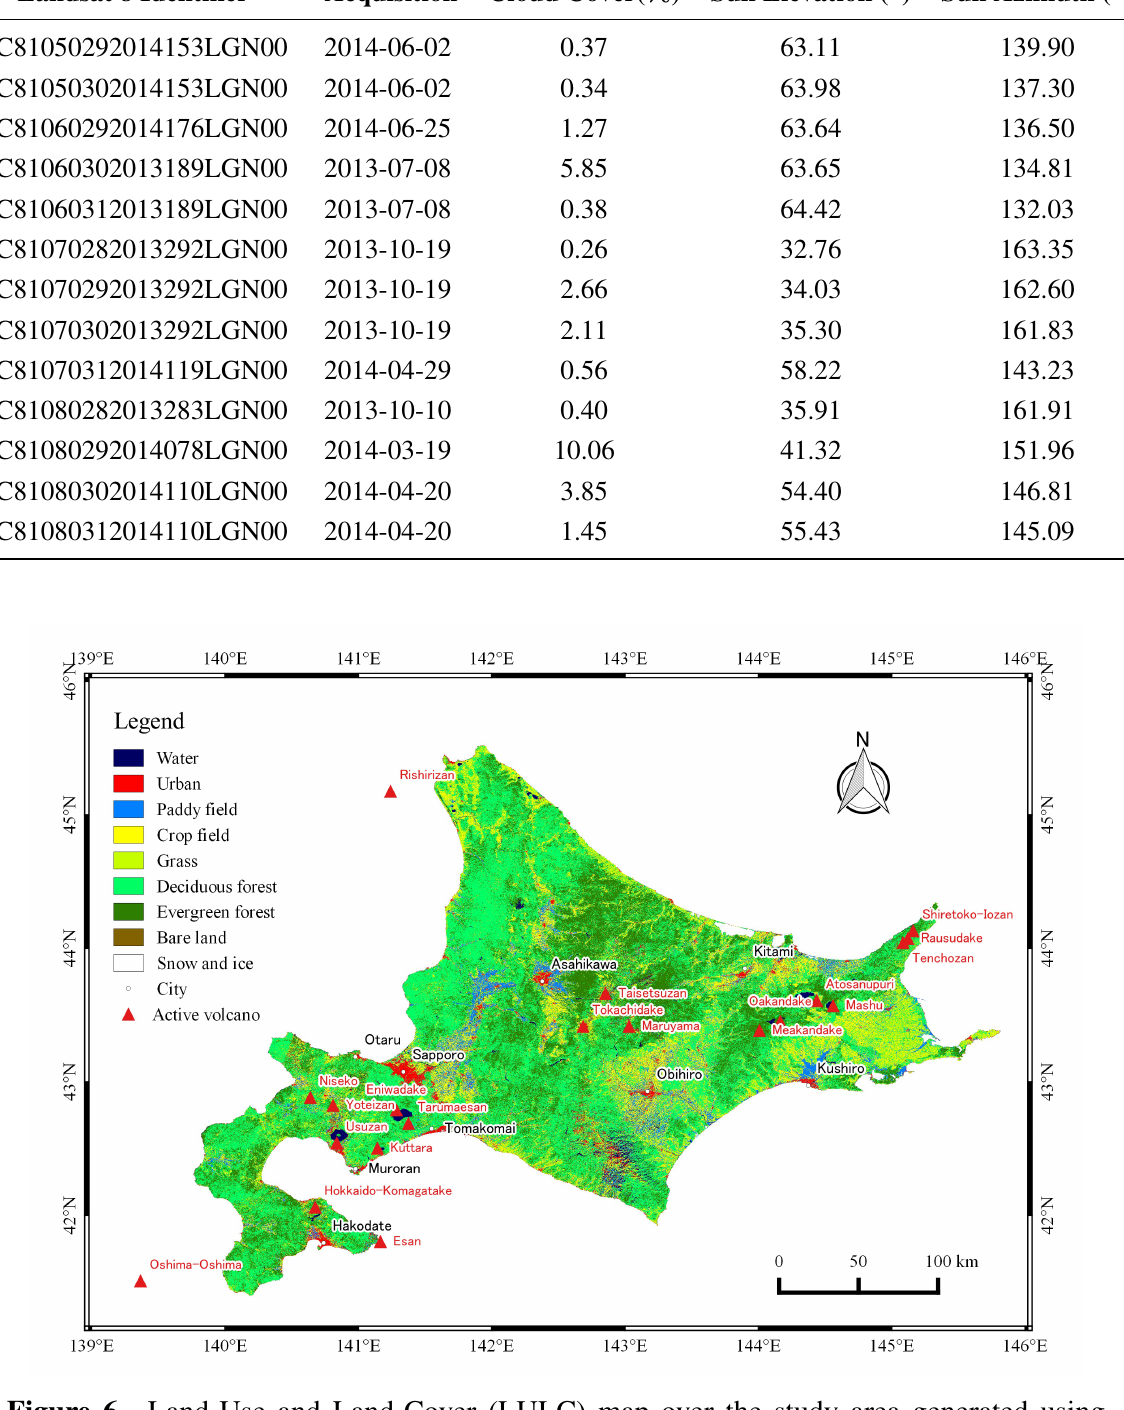
Figure 6. Land-Use and Land-Cover (LULC) map over the study area generated using the Advanced Land Observing Satellite (ALOS) Advanced Visible and Near Infrared Radiometer type 2 (AVNIR-2) image dataset by Japan Aerospace Exploration Agency (JAXA)